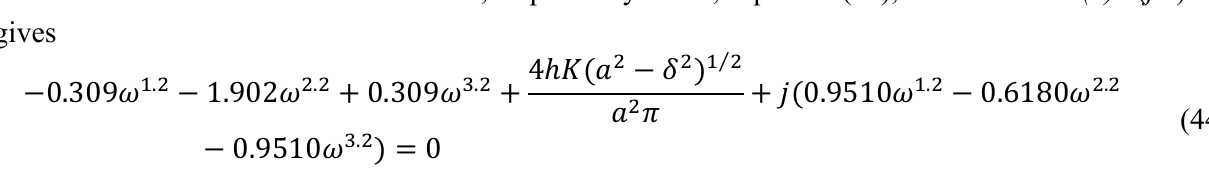
and (relay with dead 𝐺(𝑗𝜔) 𝐶(𝑎)